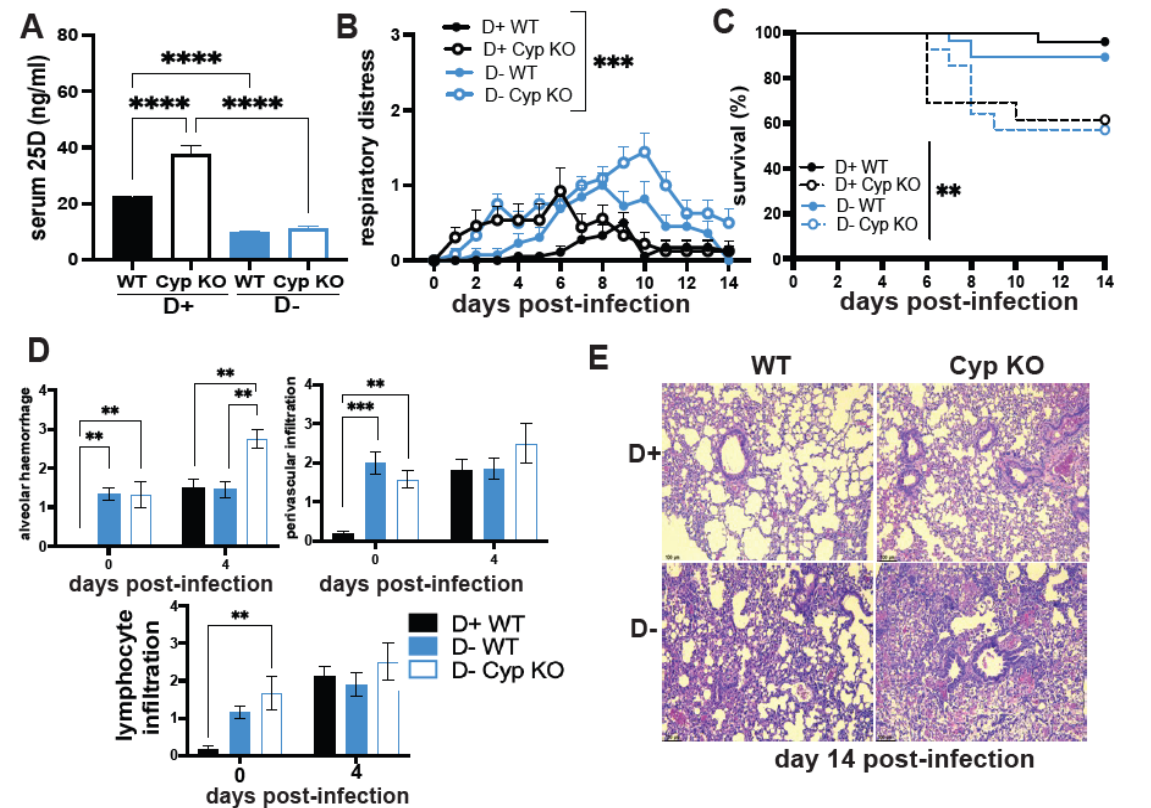
Figure 1. Vitamin D deficiency and Cyp27B1 KO increases susceptibility to H1N1 infection. D+ and D − WT and D+ and D − Cyp KO littermates were infected with H1N1 influenza ( n = 12–18 per group). ( A ) Serum was collected at day 14 post-infection to measure 25D. Mice were monitored for ( B ) respiratory distress symptoms and ( C ) survival of D+ WT ( n = 18), D+ Cyp KO ( n = 13), D − WT ( n = 13), and D − Cyp KO ( n = 12) mice until day 14 post-infection. Lung tissues were collected for histology from uninfected and day 4 post-infected mice for histology. H & E-stained sections were scored for ( D ) lung alveolar hemorrhage, perivascular infiltration, and lymphocyte infiltration in D+ WT ( n = 4) and D − WT ( n = 4–5) and D − Cyp KO ( n = 2–3) mice at day 0 and day 4 post-infection. ( E ) Representative histology of the lung of D+ WT (score = 3), D+ Cyp KO (score = 4), D − WT (score = 5.5), and D − Cyp KO (score = 6) at day 14 post-infection. Sections from D − WT, D+ Cyp KO, and D − Cyp KO show increased lymphocyte infiltration, alveolar hemorrhage and constricted bronchiolar spaces compared to D+ WT. Values are the mean ± SEM. Statistical significance was assessed using one-way ANOVA with Bonferroni multiple comparison test for ( A ) two-way ANOVA with Bonferroni multiple comparison test for ( B , D ) and log rank (Mantel–Cox) survival analysis for ( C ). ** p < 0.01, *** p < 0.001, and **** p <